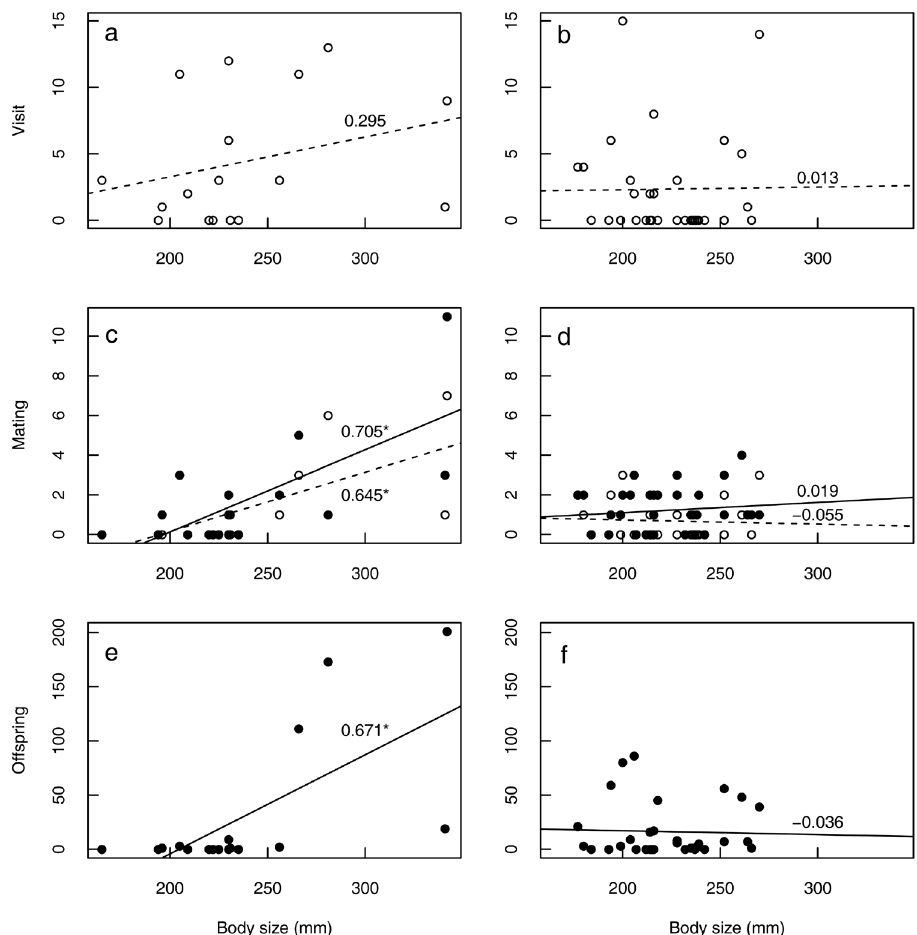
Figure 1. Linear regressions of brown trout body size against components of reproductive success for males ( a, c, e ) and females ( b, d, f ): the number of individuals of the opposite sex which were visited ( a, b ), the number of mates ( c, d ) and the number of offspring assigned ( e, f ). Open symbols and dashed lines are for behavioral data, and filled symbols and solid lines are for genetic data. For c and d, mating success was measured as the number of individuals of the opposite sex with which the focal individual was observed emitting gametes (open symbols, dashed line) and as the number of individuals with which it shared offspring (filled symbols, solid line). Values close to regression lines indicate the Pearson’s correlation coef- ficient of the corresponding regression line, with asterisk indicating p <